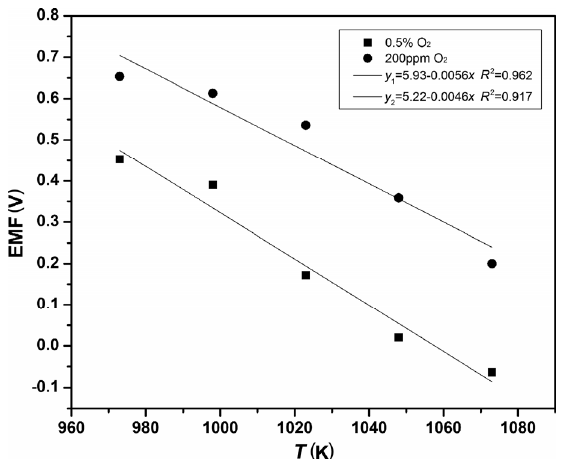
Fig. 5 Dependence of EMF on temperature in molten